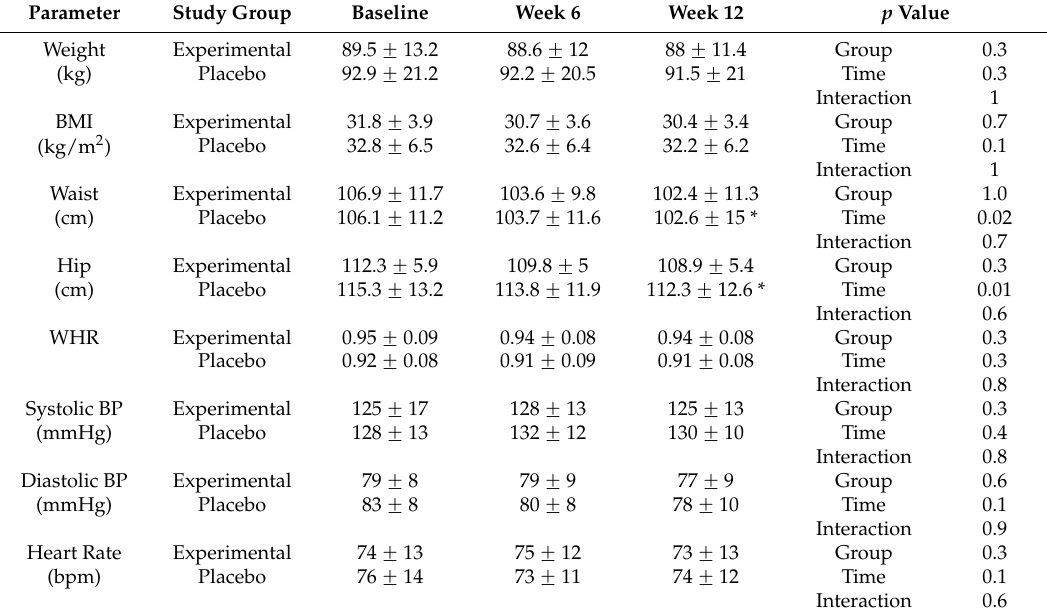
Table 2. Anthropometric and physiological parameters of participants at baseline, week 6 and week 12 of intervention with C. forskohlii extract ( n = 15 in each